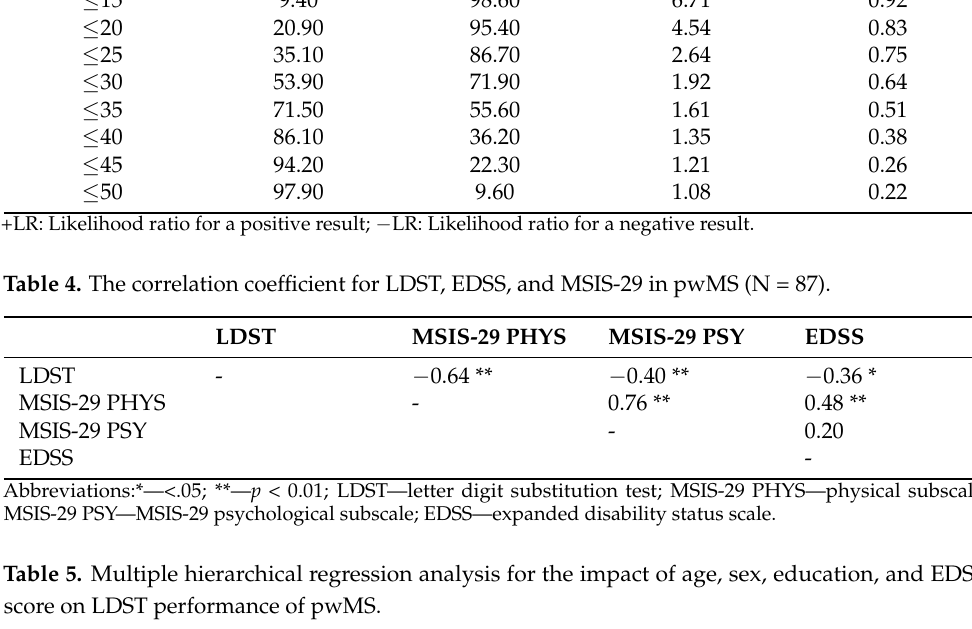
Table 3. Psychometric properties of LDST at different cut-off scores (ROC analysis). LDST Scores